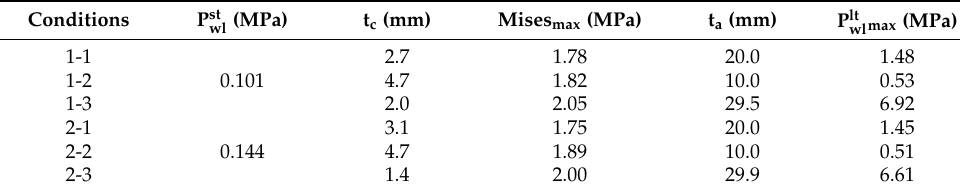
Table 4. Waterstop I waterproof capability